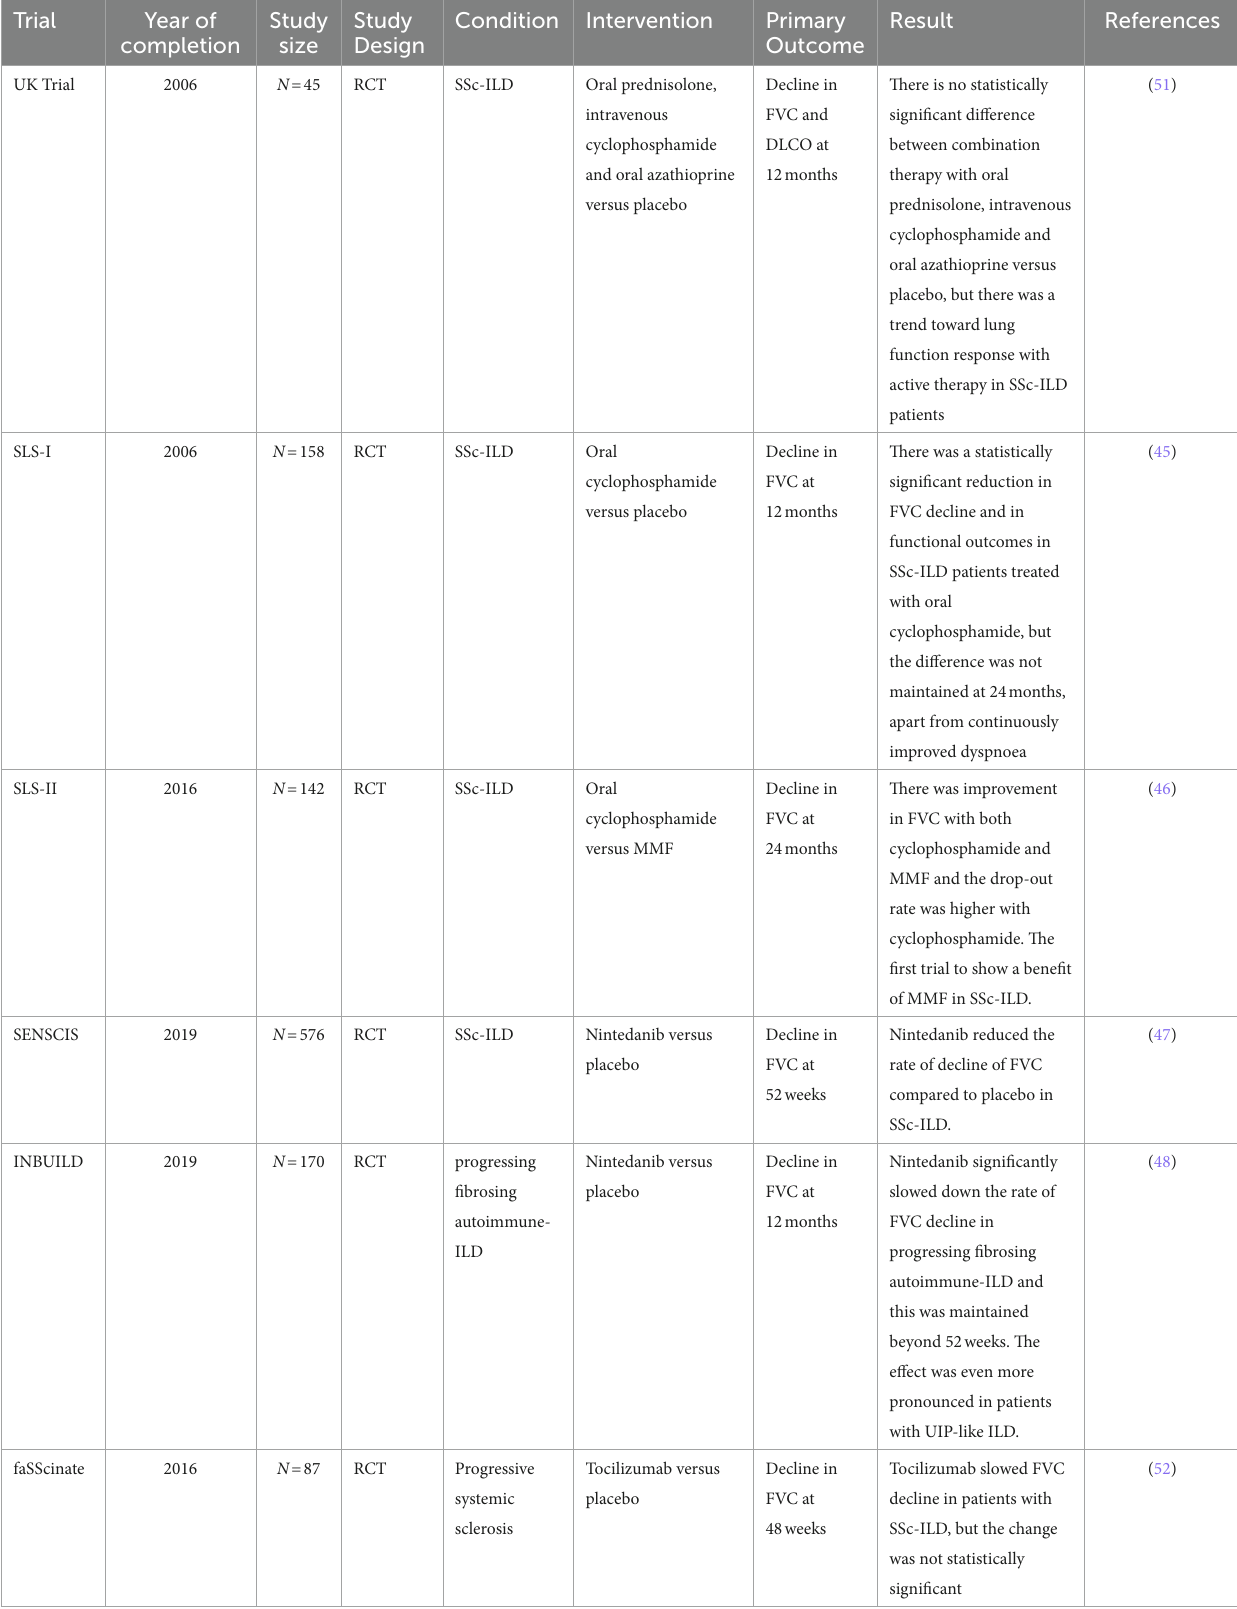
TABLE 2 Summary of recent clinical trials for pharmacological therapies in CTD-ILD.